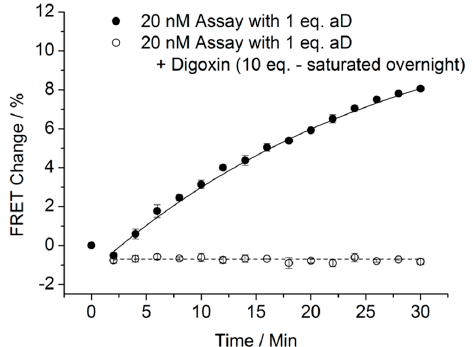
Figure 6. Inhibition of the aD with digoxin before addition to the SDC assay (20 nM, A:B:S = 1:1:1) and measurement of the FRET change over 30 min when adding either aD (20 nM, 1 eq.) (black) or adding aD (20 nM, 1 eq.) after overnight saturation with digoxin (200 nM, 10 eq.) (light gray). Experiments were performed in triplicate. The plotted values are mean values with standard deviations compared to the mean value. The FRET value at zero min (only ABS) is defined as zero, and FRET change is calculated on this basis.